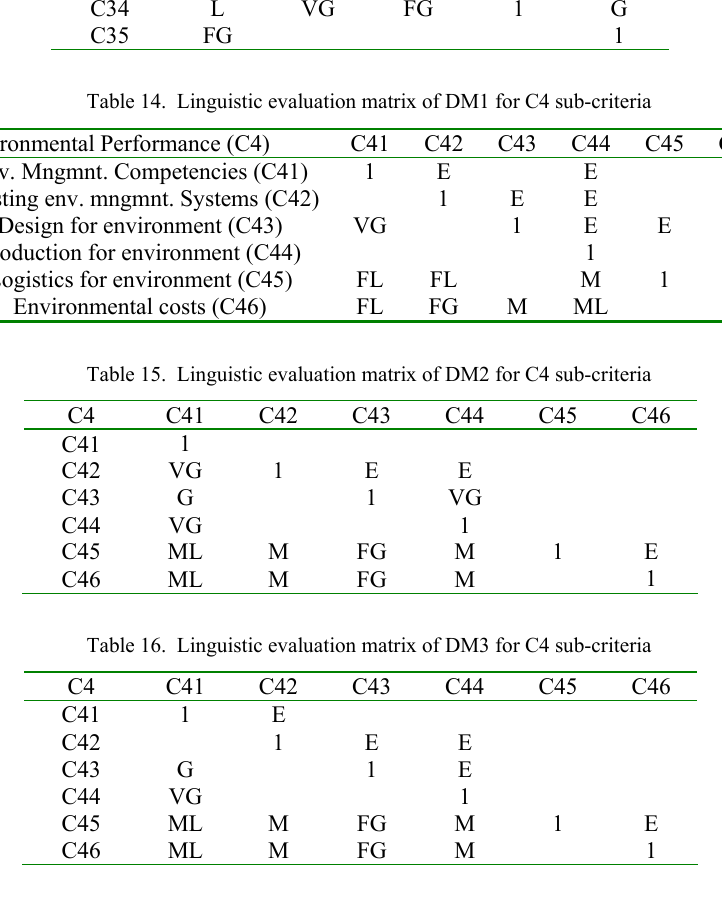
Table 17. Fuzzy aggregated evaluation matrix main